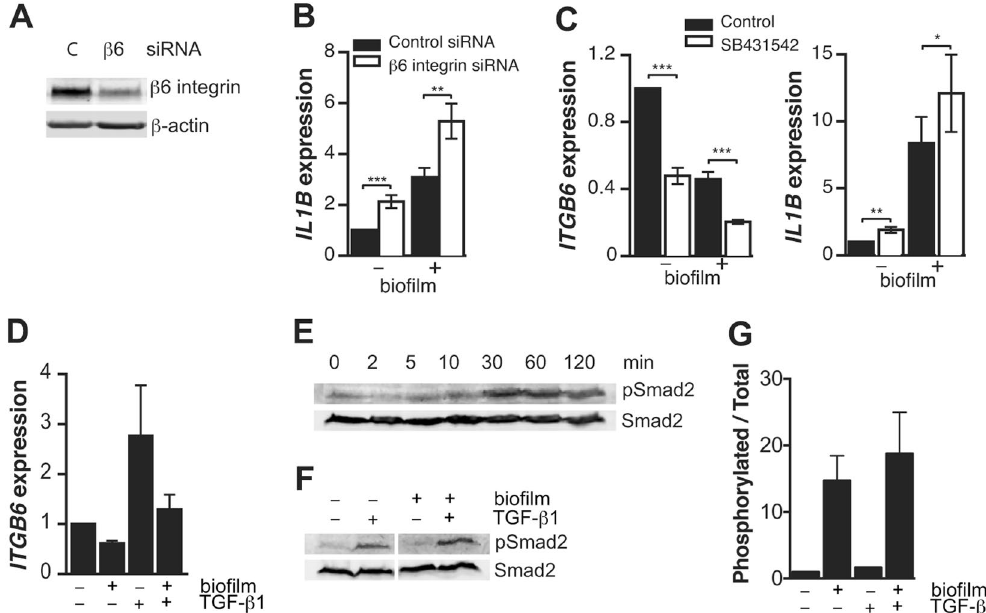
Figure 4. The effect of β 6 integrin-deficiency on inflammatory cytokine expression. ( A ) SiRNA knockdown of β 6 integrin in the GECs after a 48-h transfection relative to β -actin detected by Western blotting. SiRNA that is not homologous to any human gene ( C ) was used as a control. ( B ) The effect of β 6 integrin knockdown on IL1B expression in biofilm-treated (60 µ g protein/ml; 32 h) and non-treated GECs determined by RT-qPCR. Mean ± SEM is presented, n = 3. ( C ) The effect of TGF- β 1 signaling inhibitor SB431542 (5 µ M) on ITGB6 and IL1B expression in biofilm-treated (60 µ g protein/ml; 32 h) and non-treated GECs. Mean ± SEM, n = 3. ( D ) GECs were treated with TGF- β 1 (2 ng/ml), heated biofilm extract (60 µ g protein/ml) or a combination of both for 32 h and analyzed for ITGB6 expression by RT-qPCR. Mean ± SEM, n = 3. ( E ) GECs were treated with TGF- β 1 (2 ng/ml) for 0–120 min and analyzed for Smad2 phosphorylation (activation) relative to total Smad2 by Westerm blotting. ( F and G ) GECs were treated with TGF- β 1 (2 ng/ml), heated biofilm extract (60 µ g protein/ ml) or a combination of both for 30 min and analyzed for Smad2 phosphorylation relative to total Smad2 by Westerm blotting. The ratio of phosphorylated Smad2 to total Smad2 was determined from triplicated experiments. * p < 0.05; ** p < 0.01; *** p < 0.001.